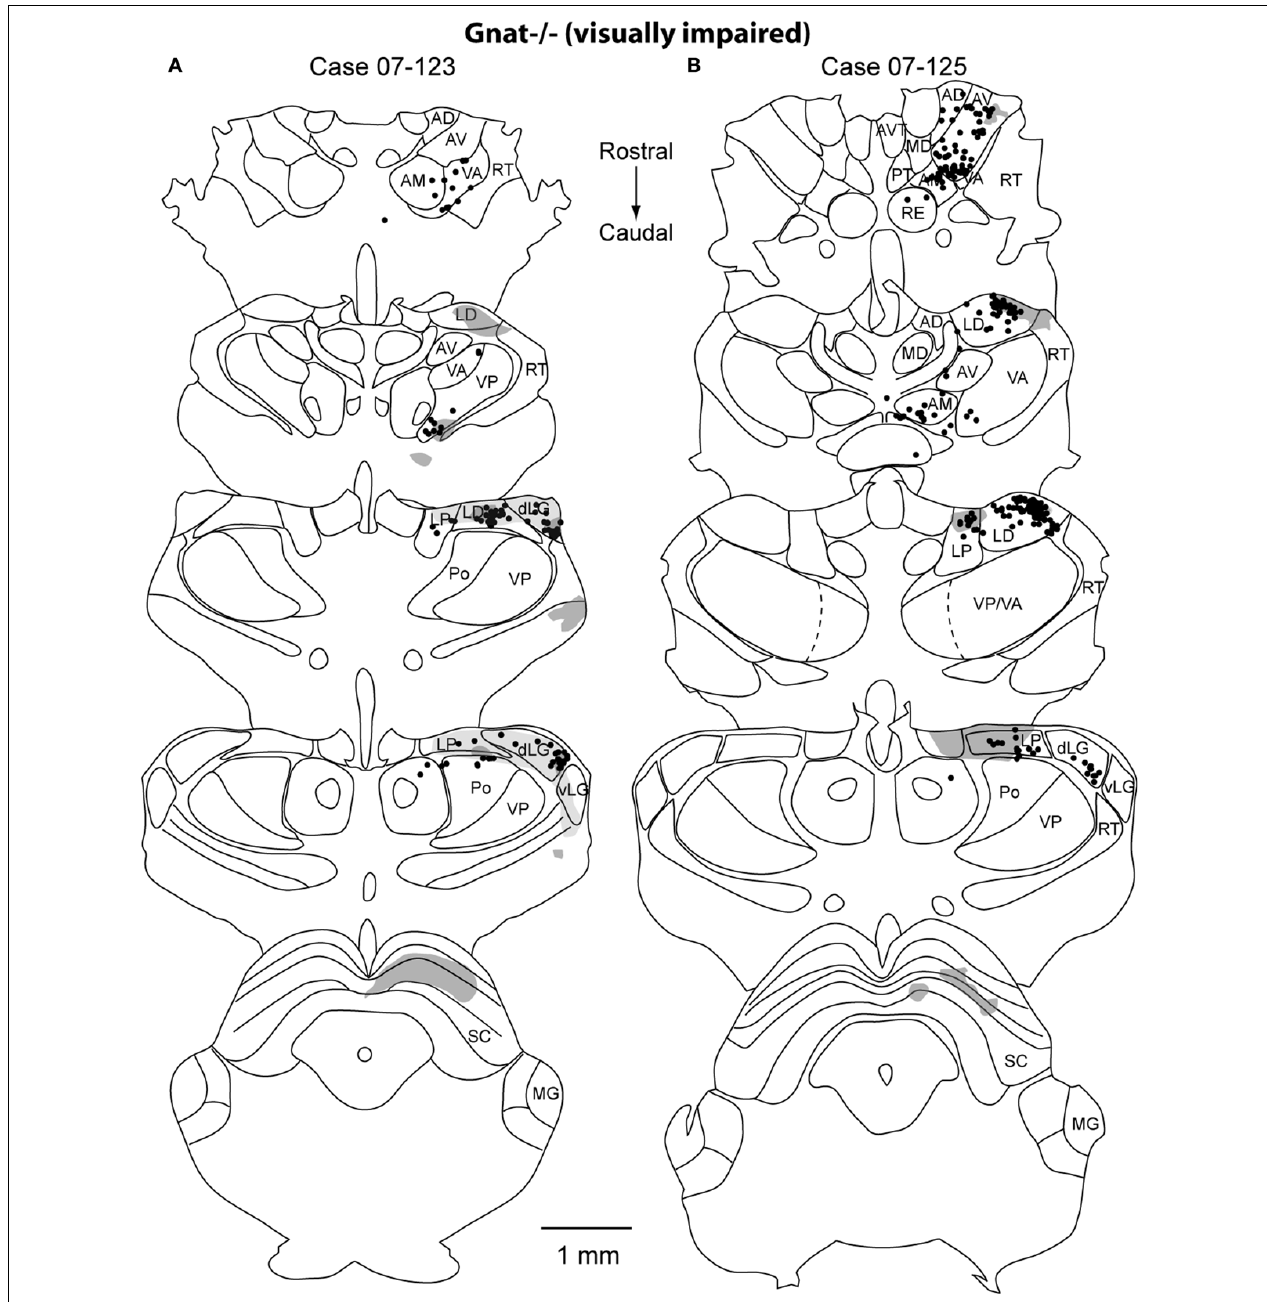
FIGURE 11 | Thalamic Reconstructions of Neuroanatomical Tracer Injections in Gnat − / − V1. Reconstructions of a series of thalamic sections sectioned in the coronal plane representing label from 2 injection sites in Gnat − / − mice (A,B) . The normal thalamocortical visual pathways (dLG, LD, LP) are found in the Gnat − / − mice. In addition, inappropriate connections are observed in Gnat − / − mice including label found in anterior group nuclei (AD, AV, AM), VA, and VP. The dots mark the